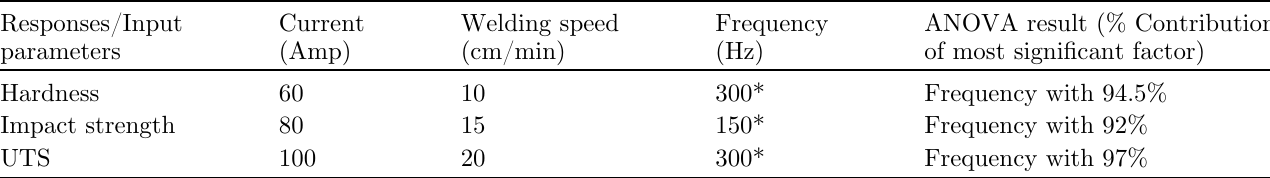
Table 12. Concluded results from Taguchi ’ s experiment and description of most signi fi cant value by ANOVA. Responses/Input